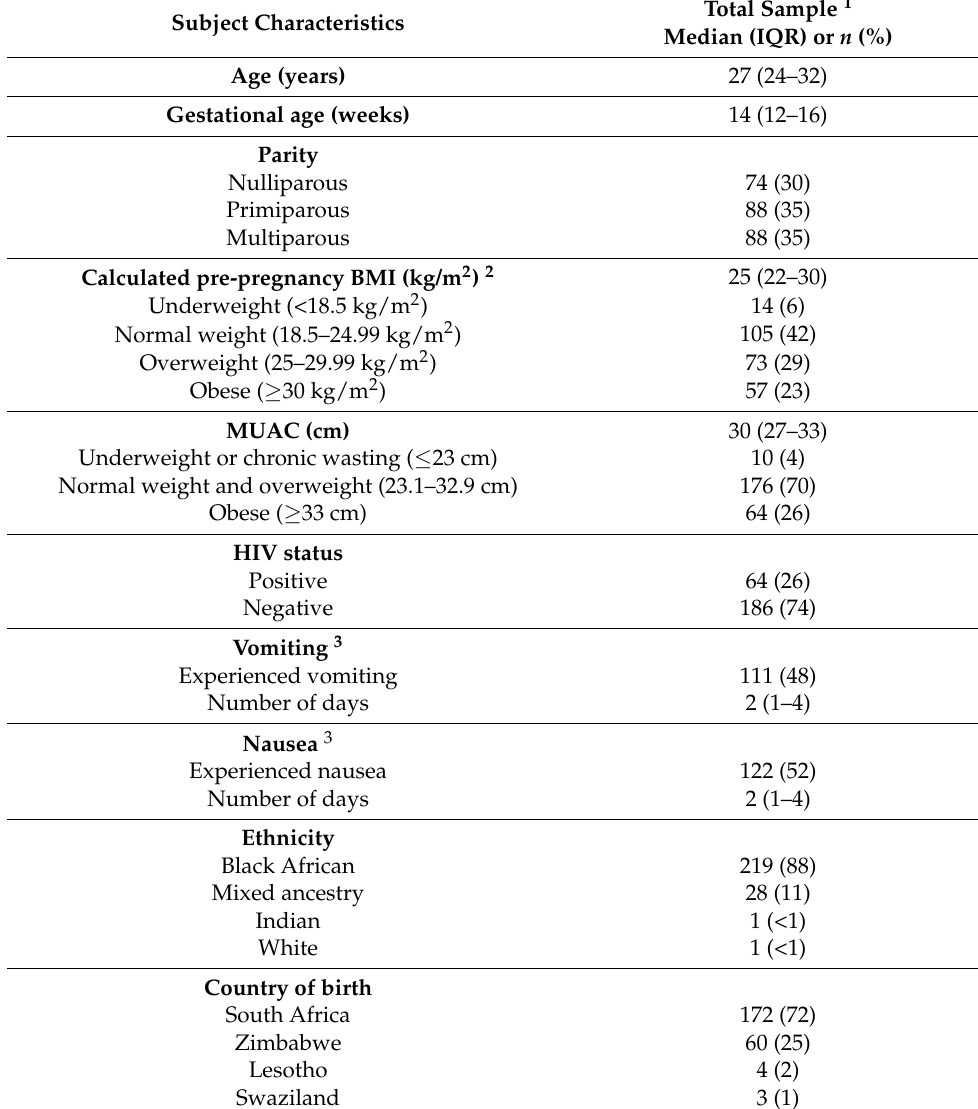
Table 2. Characteristics of study participants ( n = 250) at early pregnancy (<18 weeks’